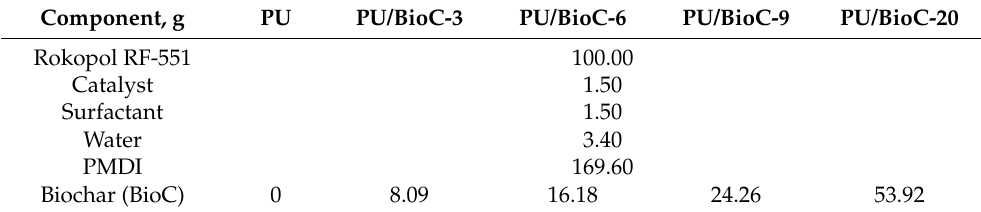
Table 1. Formulations of polyurethane systems.